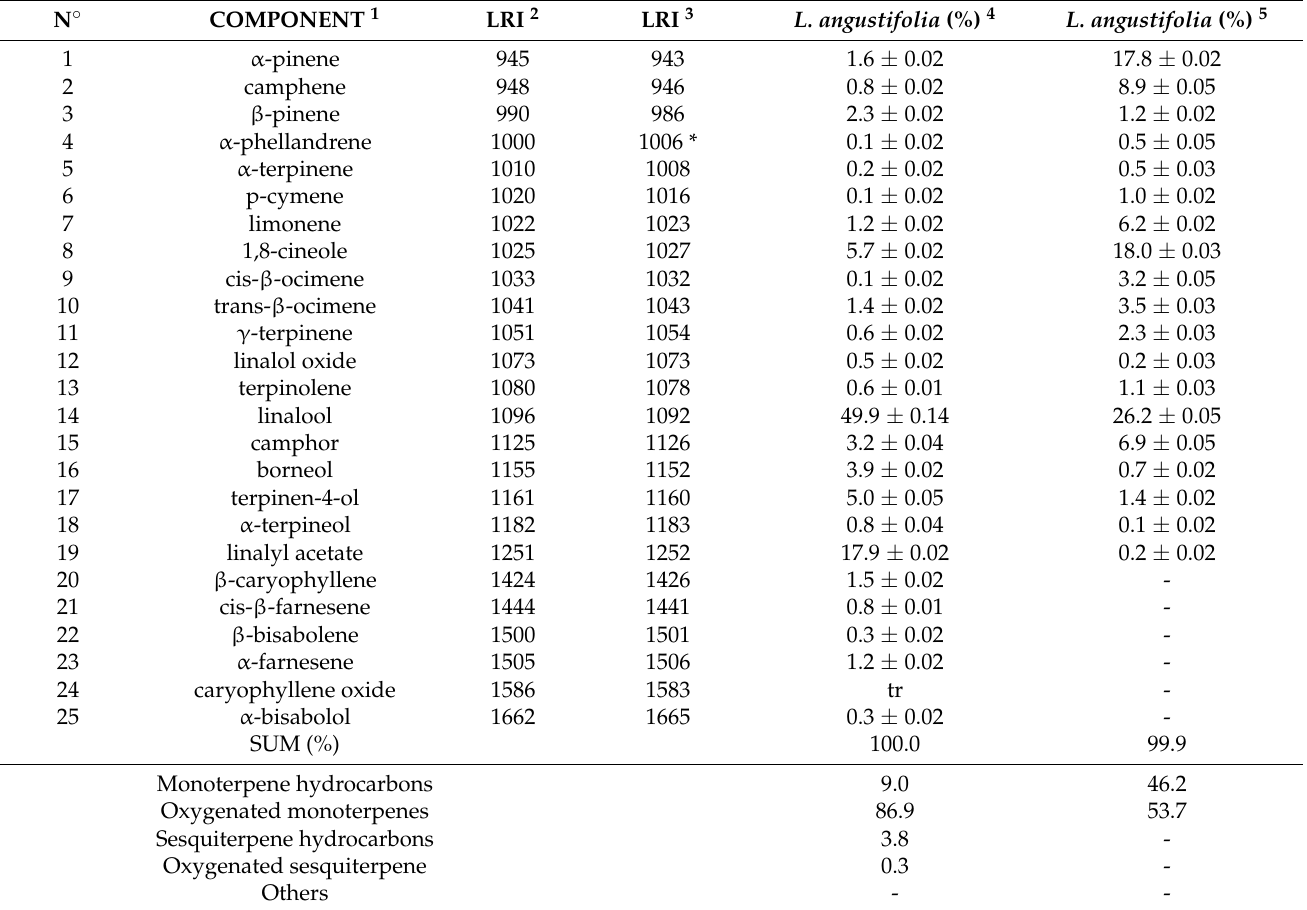
Table 2. Chemical composition (%) of liquid and vapor phase L. angustifolia EO.